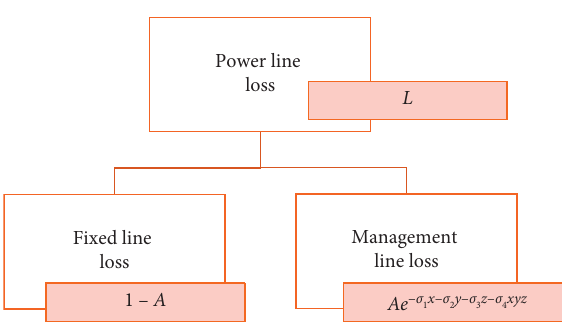
Figure 3: The line loss